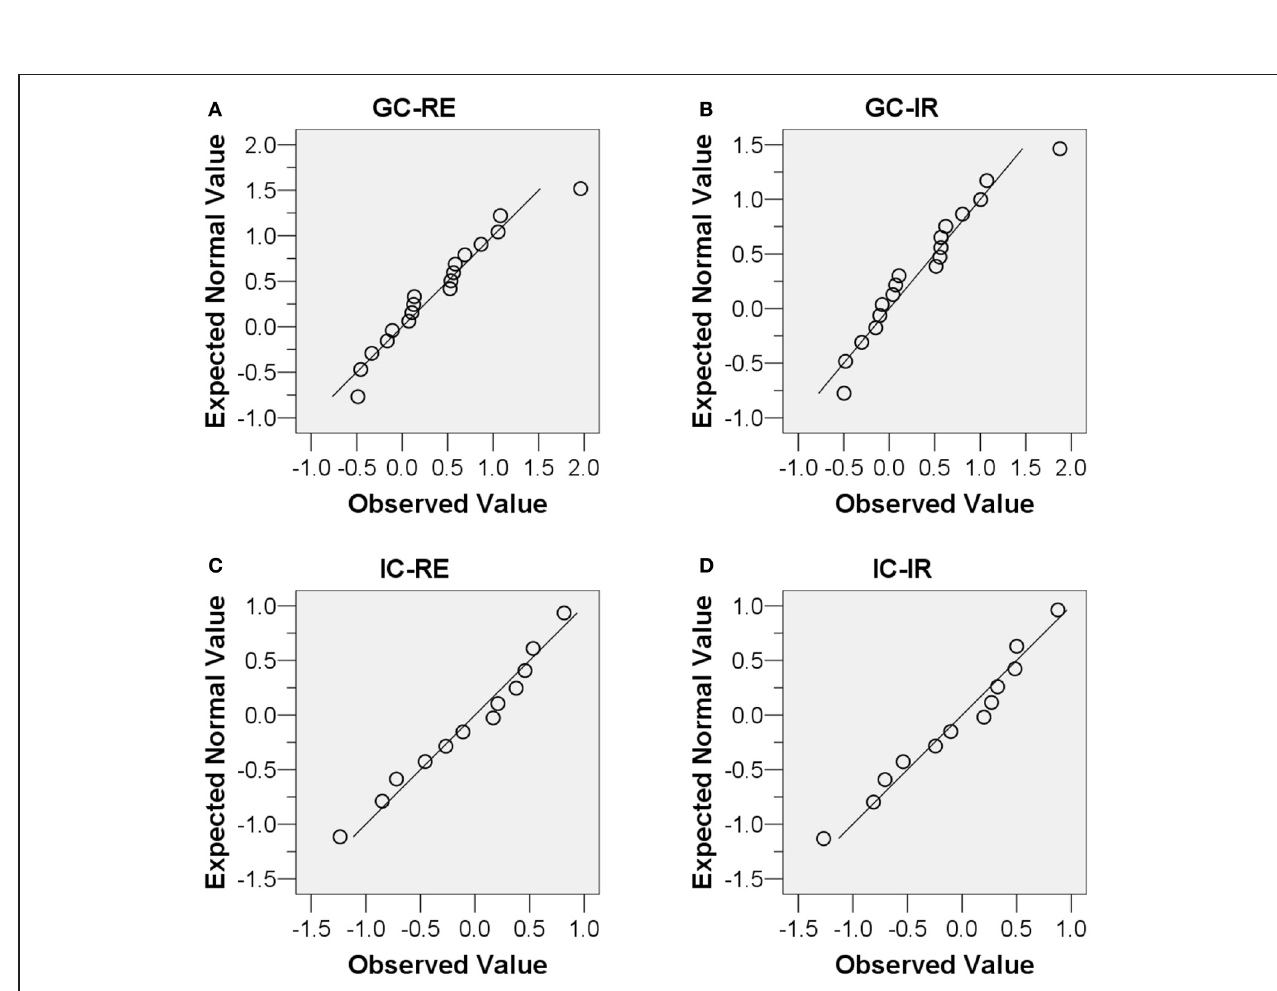
FIGURE 4 | Scatter plots of the distributions of the facial temperature change values of the (A) Guilty Condition responding to relevant sub-questions ( X -axis) and irrelevant sub-questions ( Y -axis), and (B)